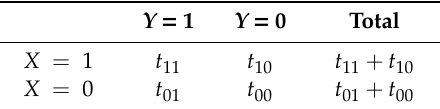
Table 1. Tabular definition of relative risk